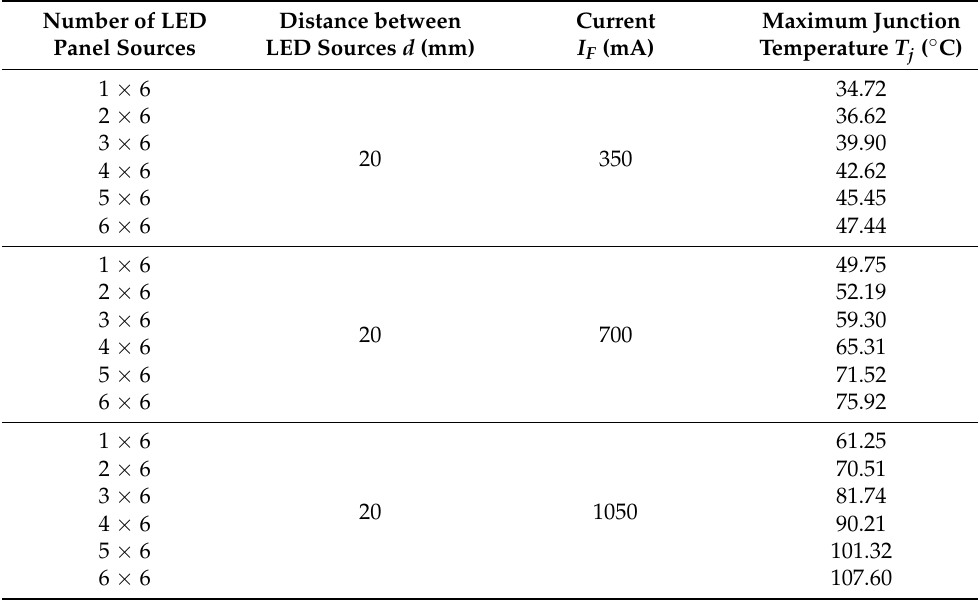
Figure 11. Temperature distribution of LED panels along the axis with the maximum temperature T j of installed LEDs for different panel configurations: ( a ) I F = 350 mA, ( b ) I F = 700 mA, ( c ) I F = 1050 mA. Table 2. The maximum temperature of the LED source junction for a panel with a variable number of